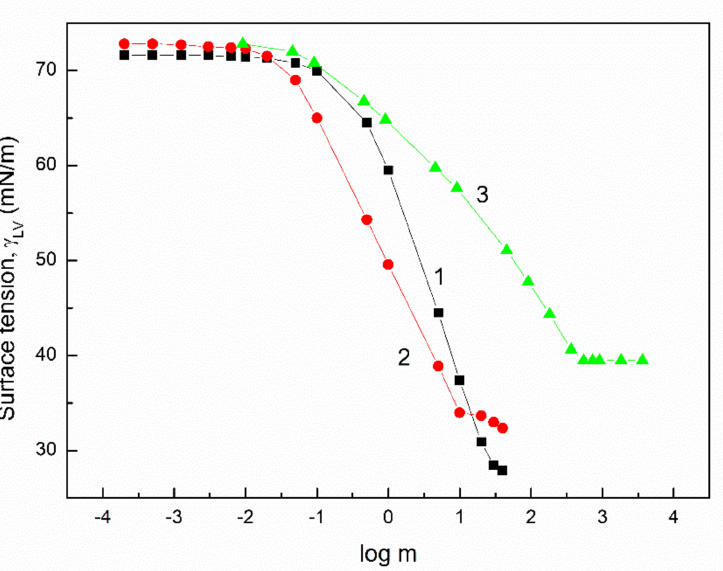
Figure 1. A plot of the surface tension ( γ LV ) of the aqueous solution of RL (curve 1), SF (curve 2), and TX165 (curve 3) vs. the logarithm from the surfactant weight in mg/dm 3